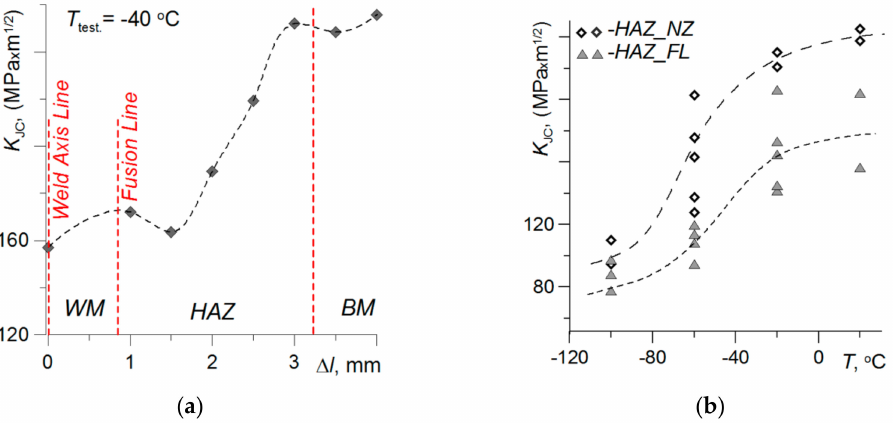
Figure 11. Critical values of K JC : ( a ) In deferent zones of welded joint; ( b ) temperature influence on change of K JC in material HAZ-FL and